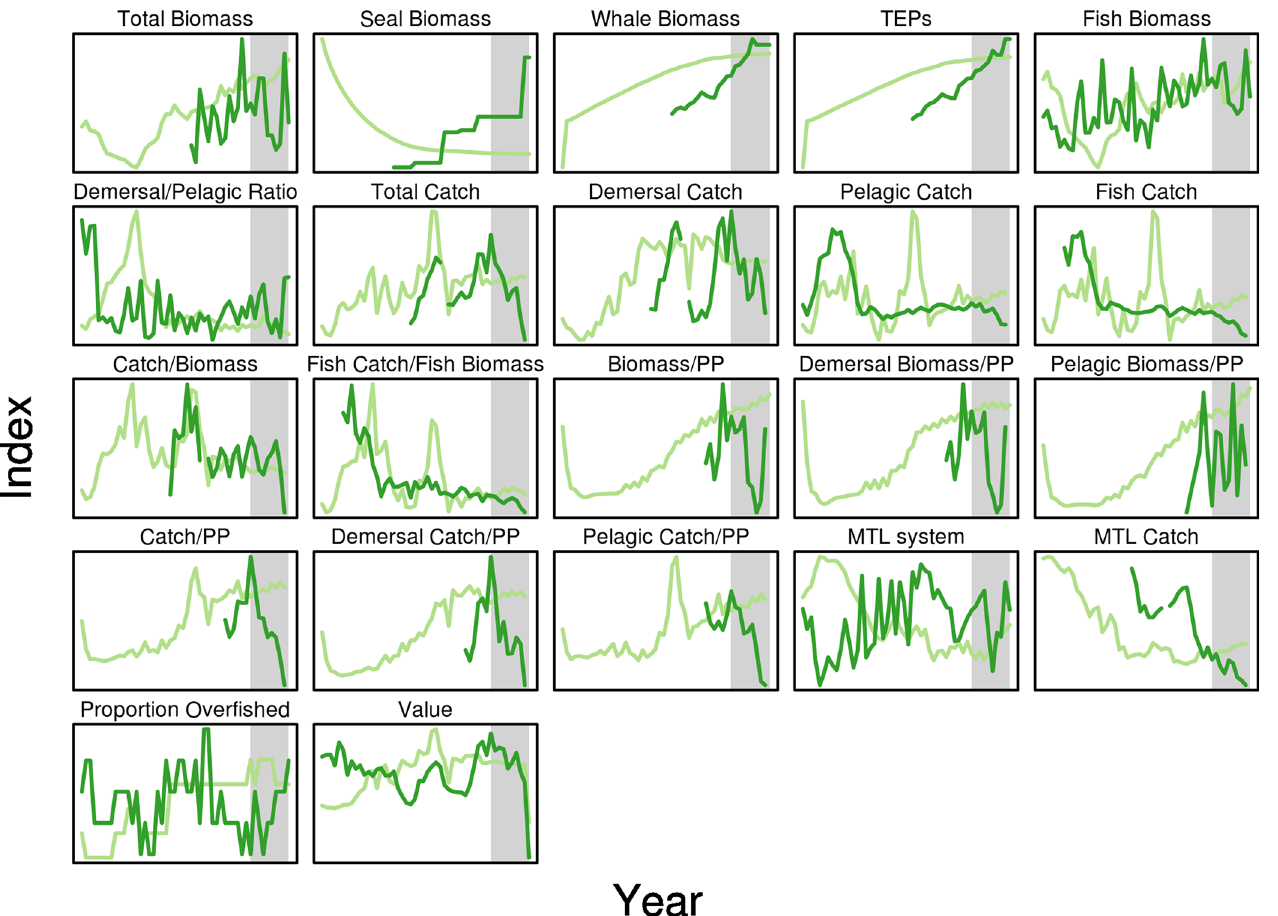
Fig 5. Time series of ecosystem indicators calculated using both Atlantis NEUS model data (dark green) and observed data (light green). Gray area indicates the forecast time-period from 2004 – 2013.